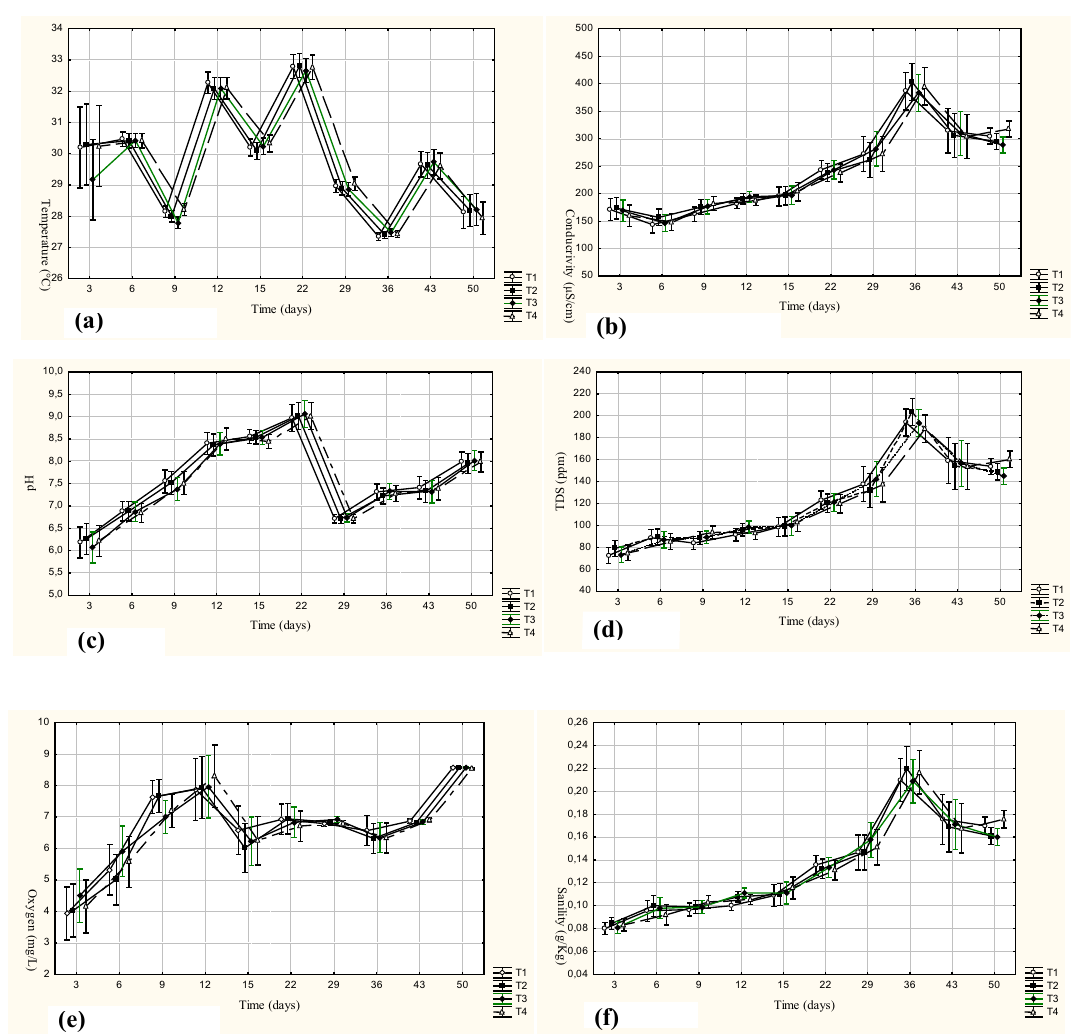
Fig. 1 Physico-chemical parameter of the various treatments accord- ing to time a temperature; b conductivity; c pH; d total dissolved solid (TDS); e oxygen; and f salinity. Treatments’ description: T